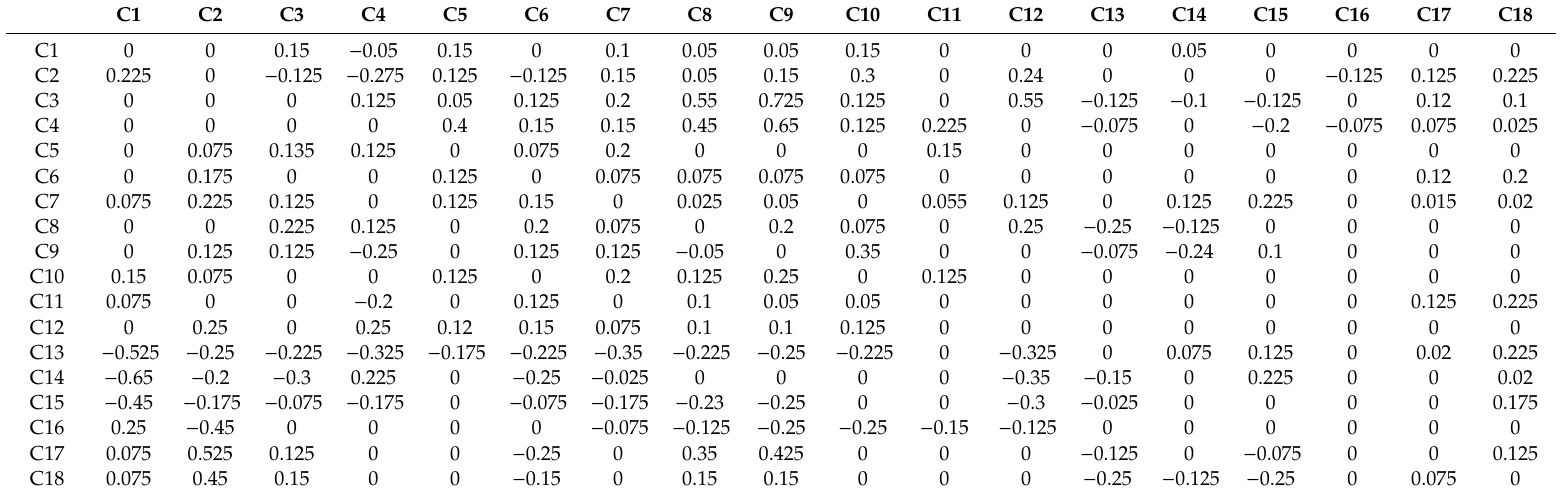
Table 4. The crisp value of the connection